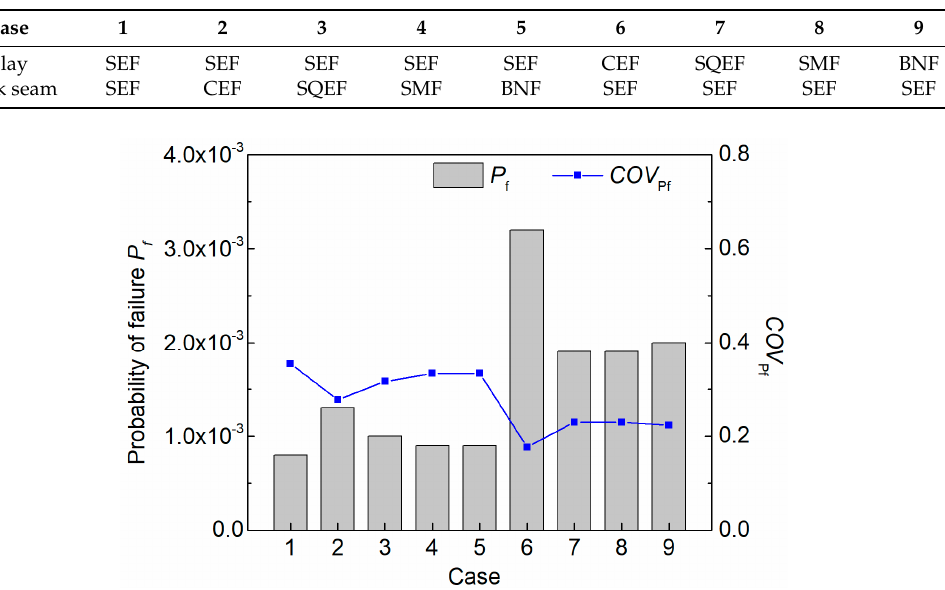
Figure 11. Probability of failure for various cases for example II.